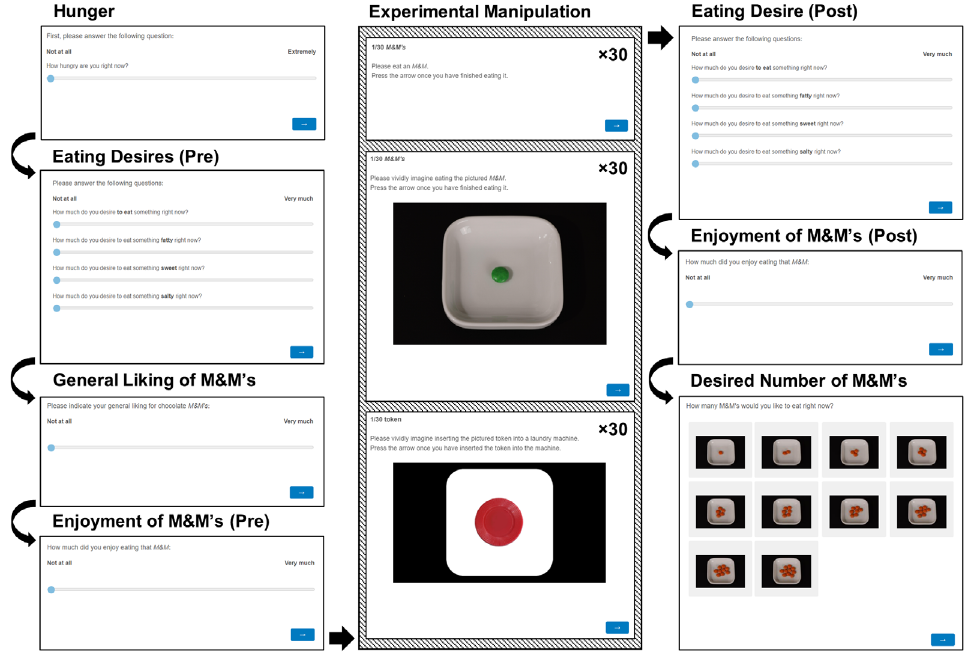
Figure 3. Visualization of the study procedure. The middle column, Experimental Manipulation, illustrates the tasks that the different groups were randomized to do, each repeated thirty times.